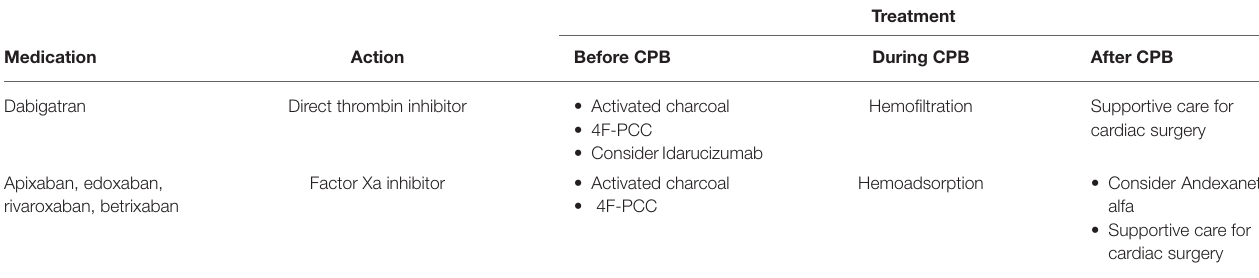
TABLE 1 | Treatment